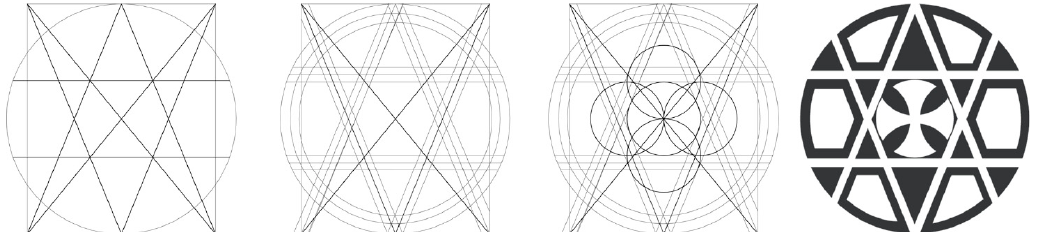
Figure 4. Figure-Ground Relationship.